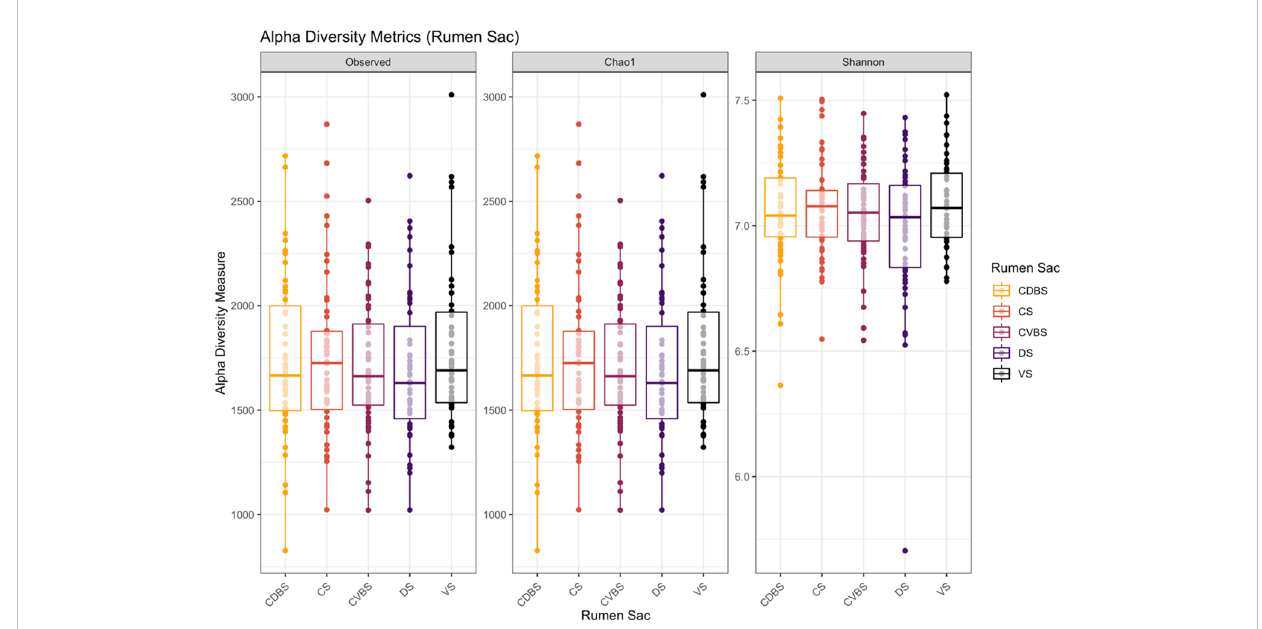
FIGURE 3 Alpha diversity metrics among the fi ve rumen sacs bacterial communities. Alpha-diversity metrics for bacterial communities within each rumen sac (includes all three fraction types within a rumen sac). Measures include observed ASVs (richness), Chao1 (expected richness), and Shannon diversity index (richness and evenness). The CDBS is denoted by orange, CS is denoted by red, CVBS is denoted by light purple, DS is denoted by dark purple, and VS is denoted by black. With the removal of singletons during data analysis, the Chao1 measurement may appear similar to the observed measurement. No signi fi cance was determined among the rumen sacs P >